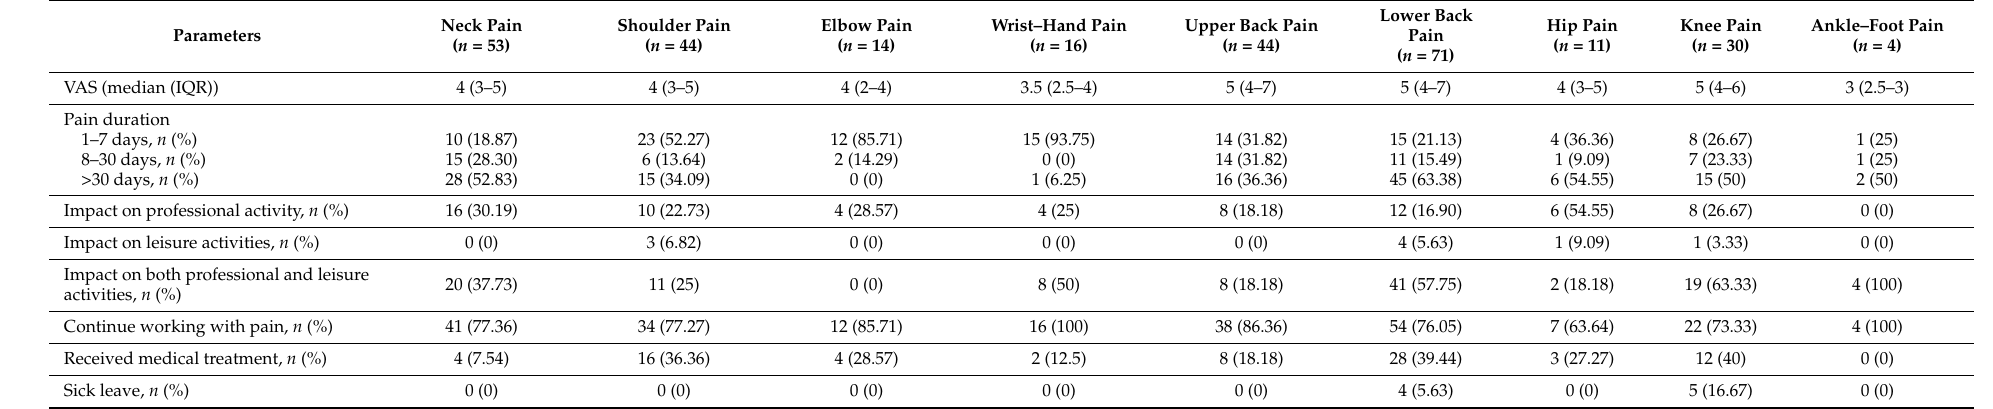
Table 4. Pain characteristics based on